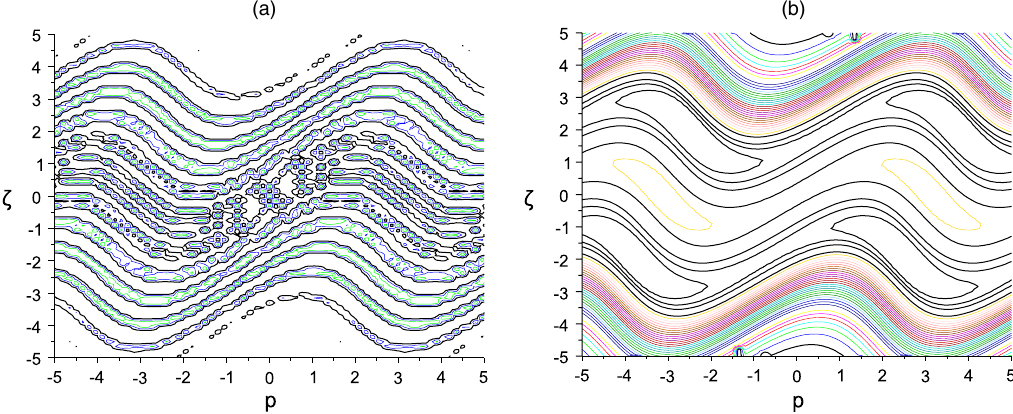
FIG. 2. Liouville distribution contour plots: (a) without Coulombian diffusion, (b) with Coulombian diffusion D ¼ 7 (cid:3) 10 (cid:1) 3